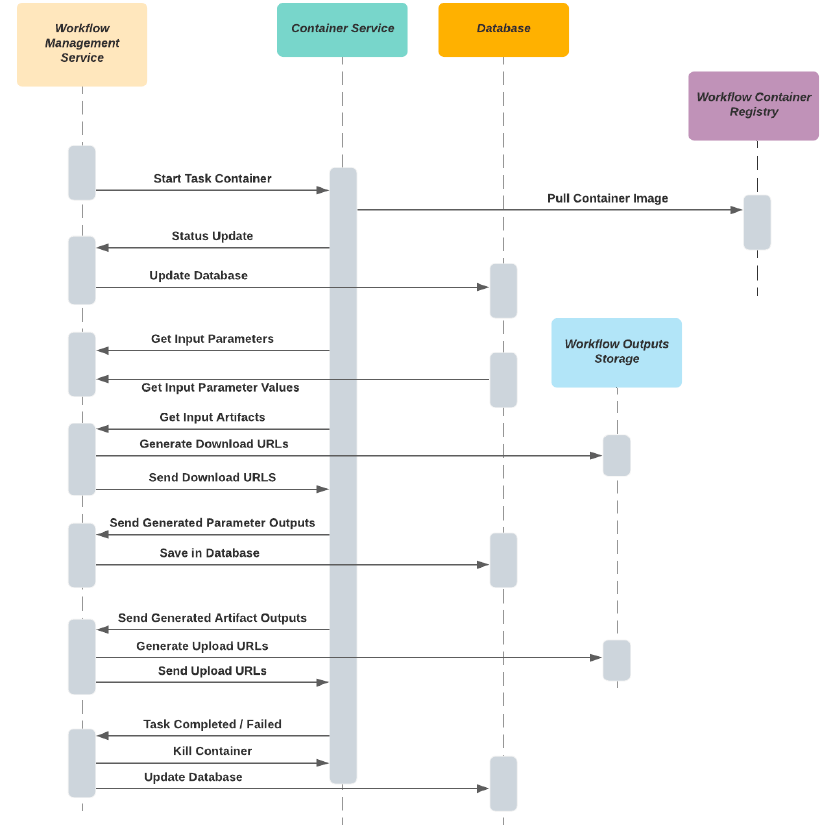
Figure 8. Workflow orchestration sequence flows.